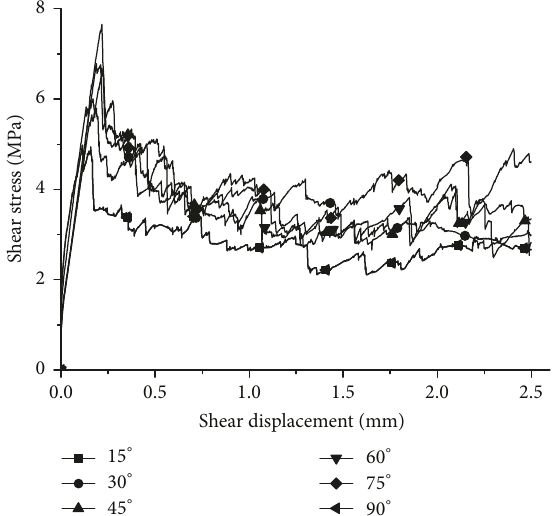
Figure 7: Evolution of the shear stress for different anchorage angles.